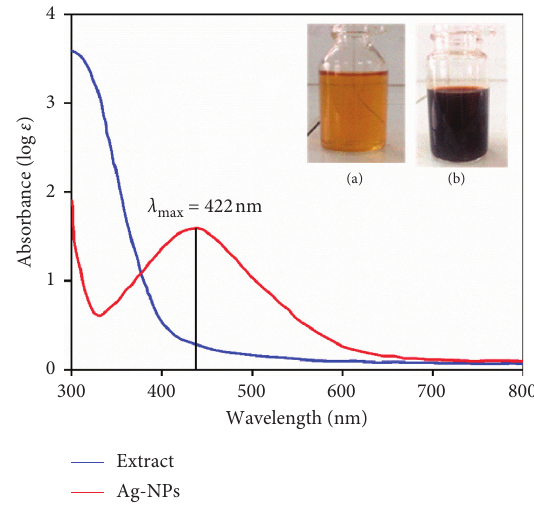
Figure 2: UV-vis absorption spectra of Ag-NPs and Centella asiatica (L.) Urban leaf extract. Inset: (a) extract and (b) silver nanoparticles.